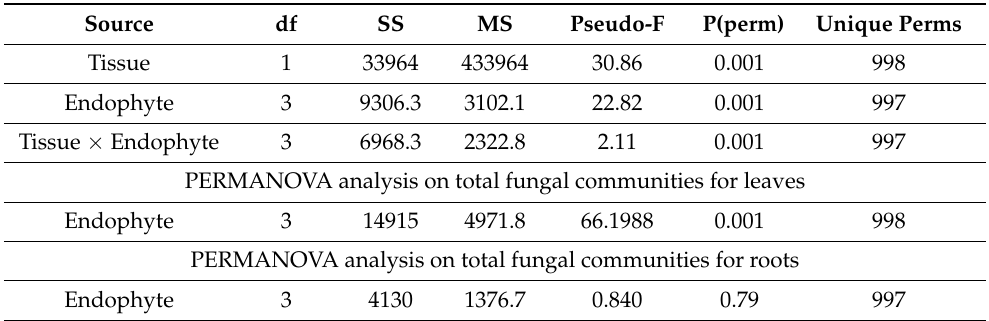
Table 1. PERMANOVA results for total fungal communities in meadow fescue. Df: degrees of freedom, SS: Sum of squares, MS: mean sum of squares, Pseudo-F: F-value by permutation, P(perm): p-values based on more than 900 permutations.